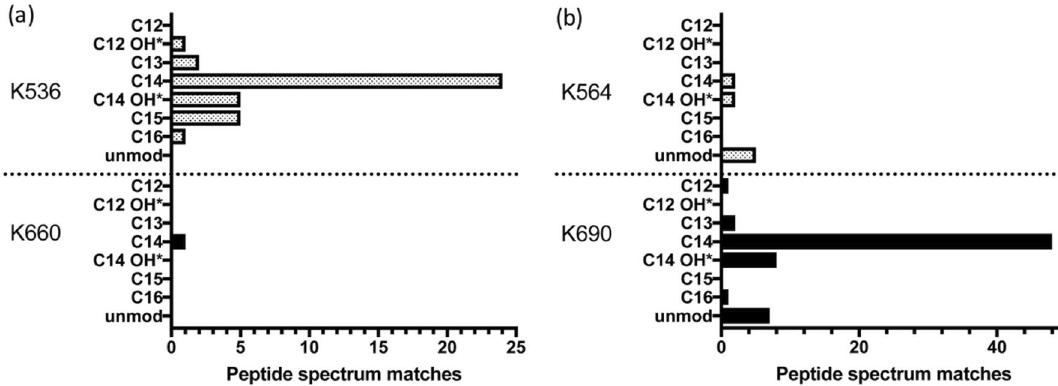
Figure 6. MS analysis of MbxA acylation ( a ) and HlyA acylation ( b ). MbxA and HlyA were in vivo acylated by co-expressing HlyC 67 . For both acylation sites in MbxA and HlyA, K536 and K660 or K564 and K690 respectively, all detected acyl modifications ranging from C 12 to C 16 fatty acids including hydroxy fatty acids are shown with the corresponding number of recorded PSM. Mass shifts contributing to hydroxy fatty acids could possibly originate from the oxidation of tyrosine residues in the peptide fragment and PSM of supposed hydroxy acylations are therefore marked (*). For proMbxA and proHlyA, both expressed in the absence of HlyC, only unmodified peptides were detected. Acyl modifications were detected only in peptides covering the predicted lysine residues K536 and K660 of MbxA. The PSM of C 14 modified sequences suggest that the predominant modification is